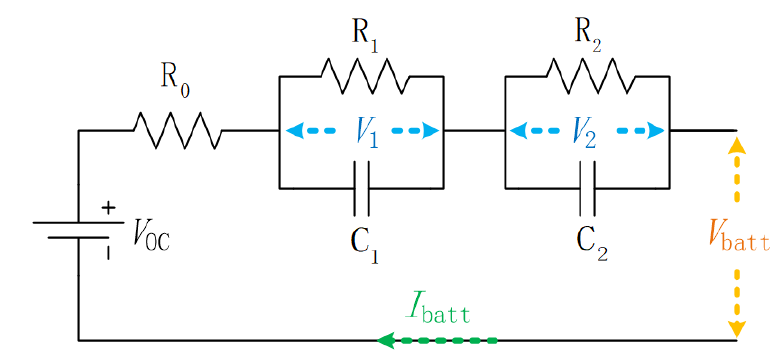
Figure 2. Battery equivalent circuit model (ECM) with the double RC